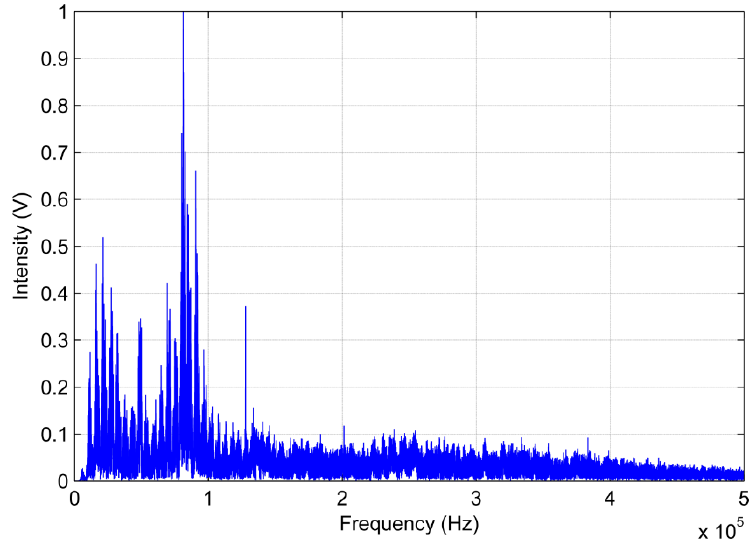
Figure 14. Frequency response of the piezoelectric diaphragm.